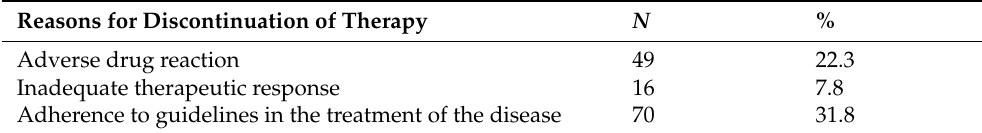
Table 5. Physicians’ reasons for discontinuation of PPI therapy ( N = 135).